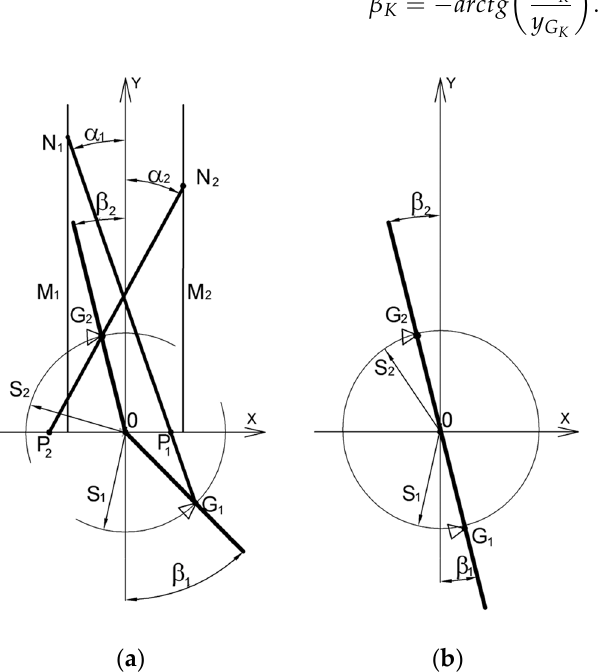
Figure 13. The conical contact surface of the platter: general ( a ) and simplified ( b ) case studies.